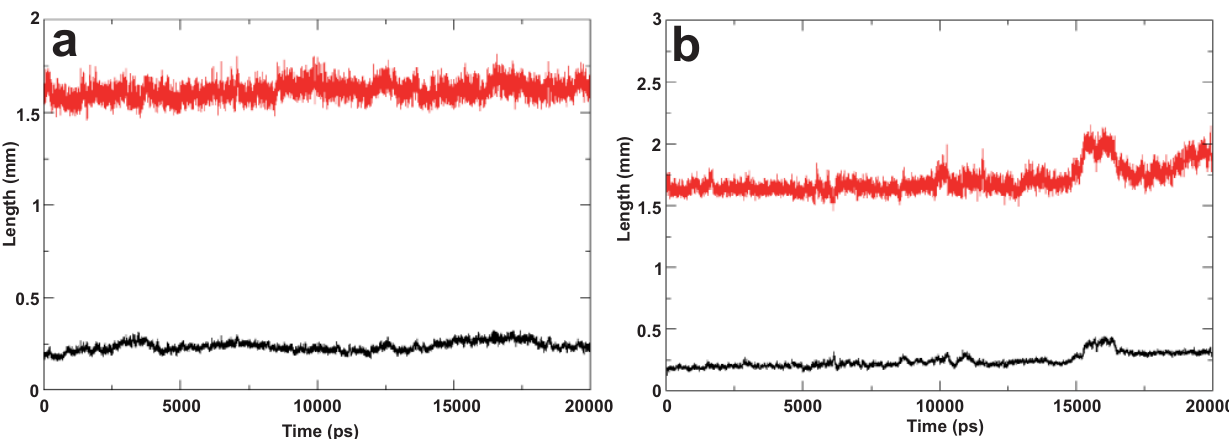
Figure 3. Helix length and RMSD of the ideal helix model and 2KZQ structures. ( a ) Molecular dynamics simulation of the ideal helix model. The amphipathic segment was positioned in water-lipid interface and the transmembrane domain was oriented in the hydrophobic core of the bilayer. The length of the helix (segment residue 689–703) is plotted in red, root mean square deviation (RMSD) of the same residues with respect to the starting structure is plotted in black. ( b ) Molecular dynamic simulation of the nuclear magnetic resonance derived structure (2KZQ.pdb). 2KZQ was positioned in the water-lipid interface. The length of the helix segment is plotted in red; RMSD of the same residue with respect to starting structure is plotted in black.